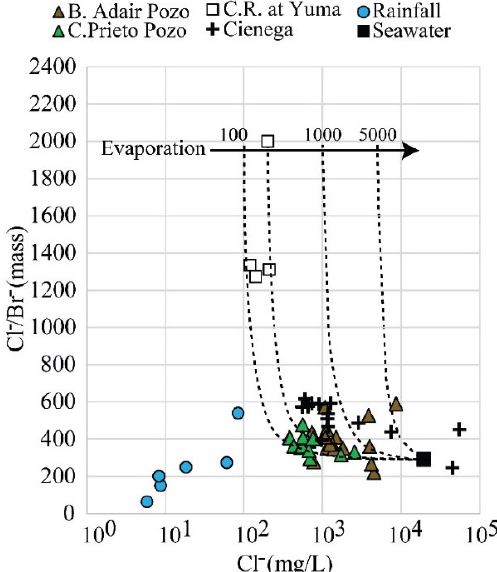
Figure 12. Cl − /Br − (mass) vs. log Cl − (mg/L) for surface and groundwaters used in this study. Dashed lines show hypothetical mixing lines between seawater—or whole salt as aerosols—in one end, and Colorado River water with different Cl - concentrations at the other.